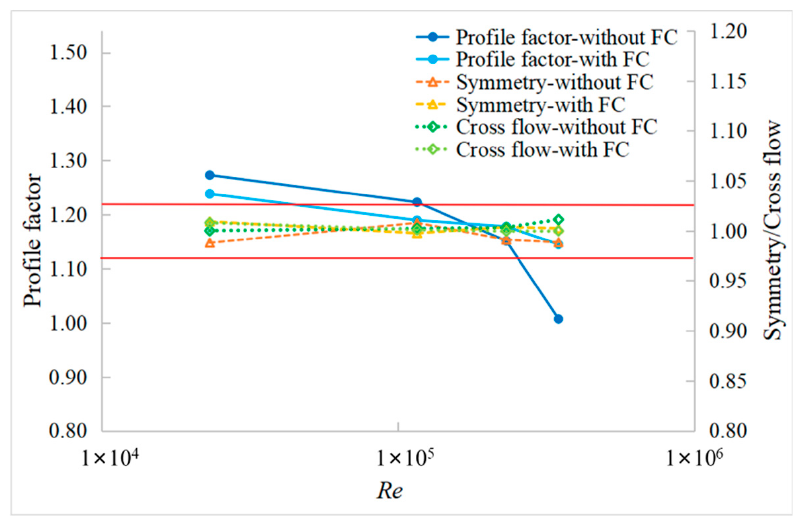
Figure 20. Characteristic parameters at 19D corresponding to the experimental condition.